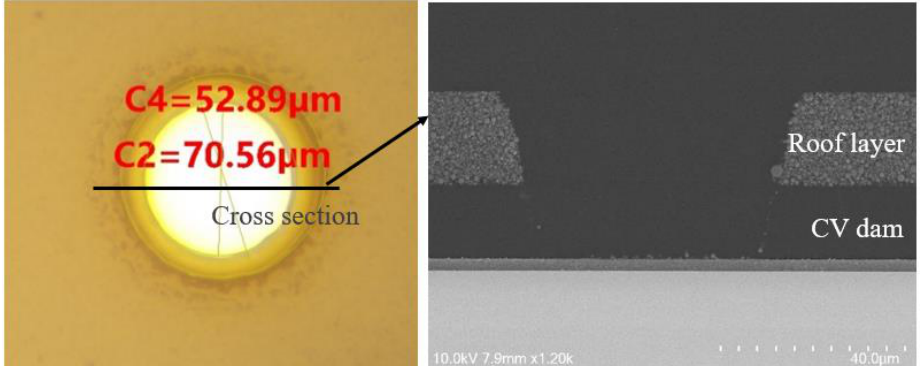
Figure 3. Top view of the opening size of the CW dam and roof layer.